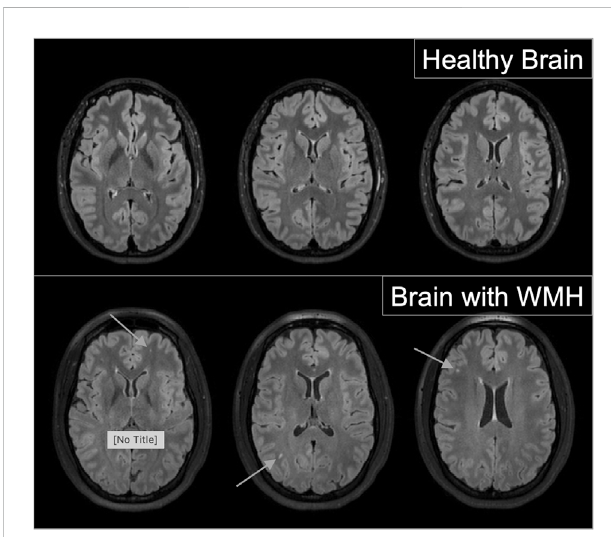
FIGURE 2 Examples of healthy brain images (top panel) and images from brainswithevidenceofwhichmatterhyperitensities(bottompanel)from fl uid-attenuated Inversion Recovery (FLAIR) magnetic resonance